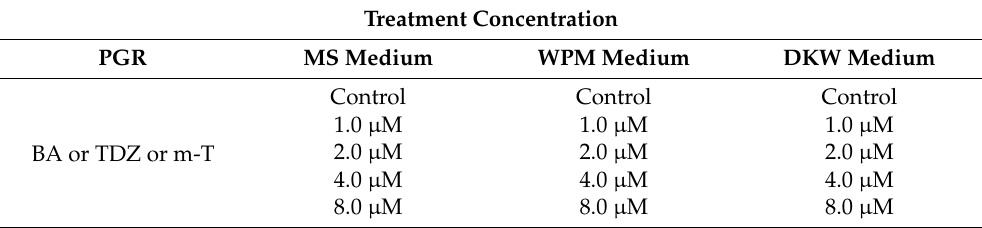
Table 1. Treatments used in the shoot regeneration experiments for both the female and male explants.